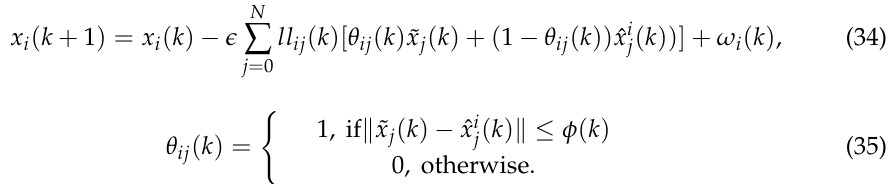
( k ) is the state value estimated by j ( k ) j